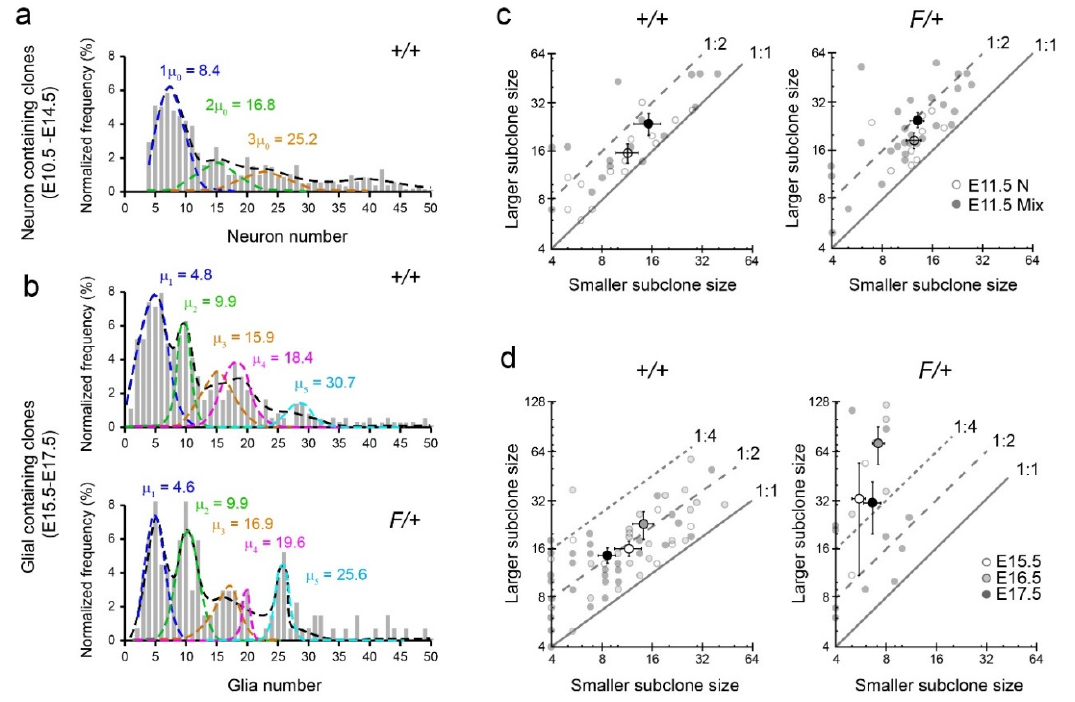
Figure 5. Gliogenesis exhibits a stochastic pattern of clonal expansion in the cortex. ( a ) Gaussian curve fitting for analysis of size distribution of clones versus their normalized frequency for early neurogenic clones (E10.5–E14.5). Values for the histogram and Gaussian curves were extracted manually using the WebPlotDigitizer (https://automeris.io/WebPlotDigitizer/citation.html) from Gao et al. [1]. ( b ) Gaussian curve fitting for analysis of size distribution of clones versus their normalized frequency for gliogenic clones (E15.5–E17.5). ( c ) Scatterplot presenting the size (number of cells) of larger versus smaller sibling subclones of individual clones during the neurogenic period at E11.5 in +/+ and F /+ cortices. ( d ) Scatterplots presenting the size (number of cells) of larger versus smaller sibling subclones of individual clones during the gliogenic period in +/+ and F /+ cortices. White, black, and gray dots with error bars represent mean ± sem, faded dots indicate individual clones, and the slopes indicate ratio boundaries as indicated in both ( c , d